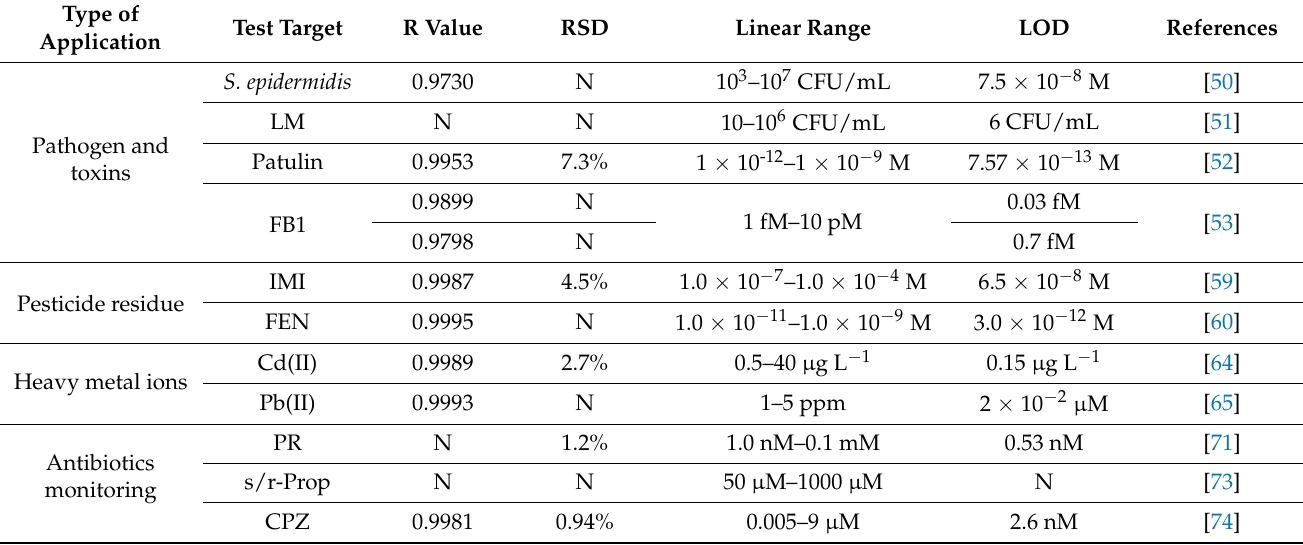
Table 1. Summary of MIECs methods in different applications (not given: